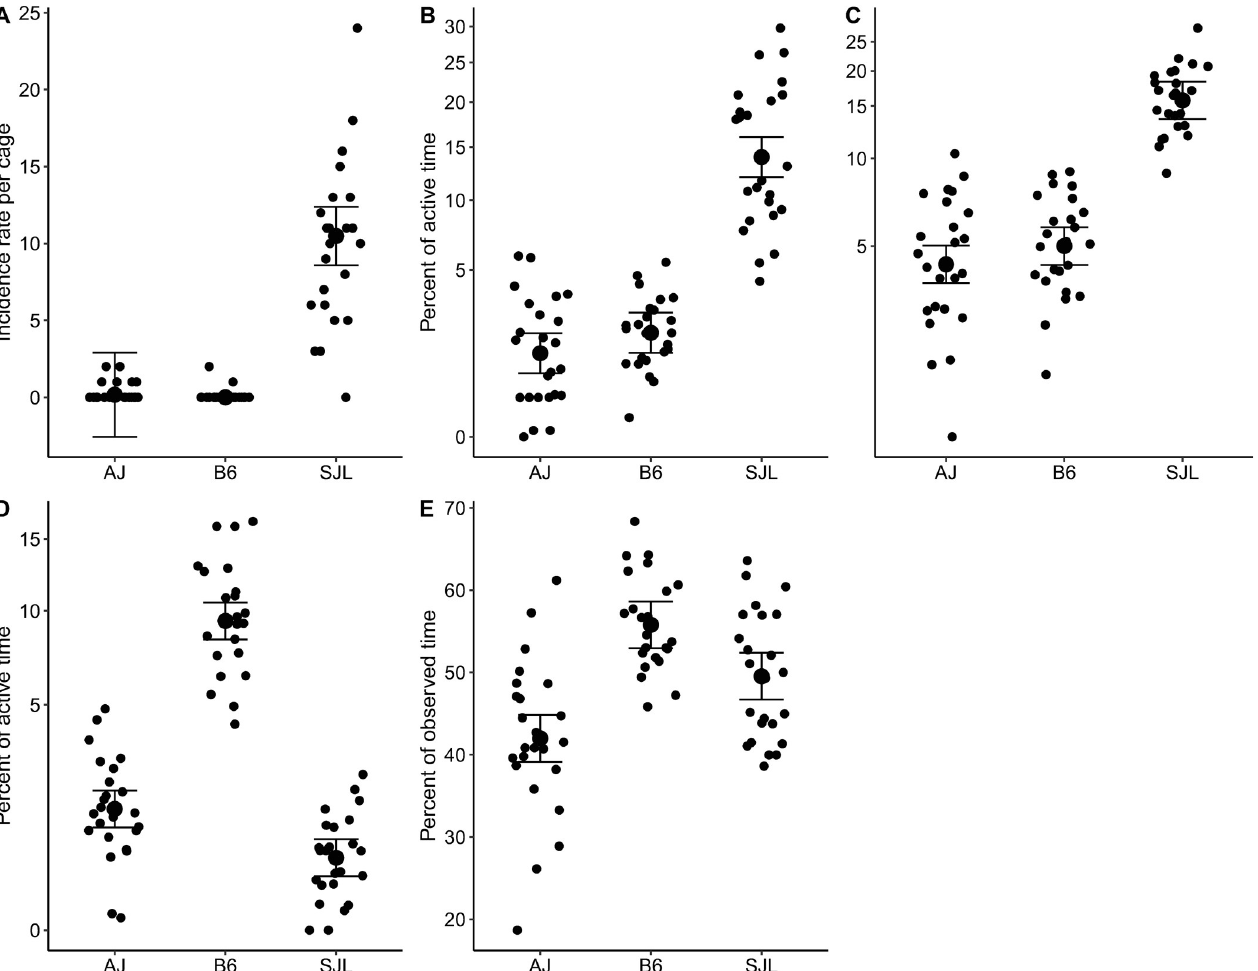
Fig 3. Aggressive and affiliative behavior patterns varied according to strain. SJL mice had (A) the highest rate of escalated aggressive behaviors (occurrences per day; p = 0.018). They also spent the highest percent of active time performing (B) mediated aggression (p < 0.001) and (C) social investigation (p < 0.001) behaviors. B6 mice spent the highest percent of active time (D) allo-grooming (p < 0.001) and highest percent of observed time in (E) group sleep (p = 0.006). All data are presented as strain LSM +/- SE with the scatter of the individual data points’ residual differences from the LSM (N = 72, 3 observations from 24 cages). Y axes are shown on a square root back transformed scale in B and D, and on a log 10 back transformed scale in C.